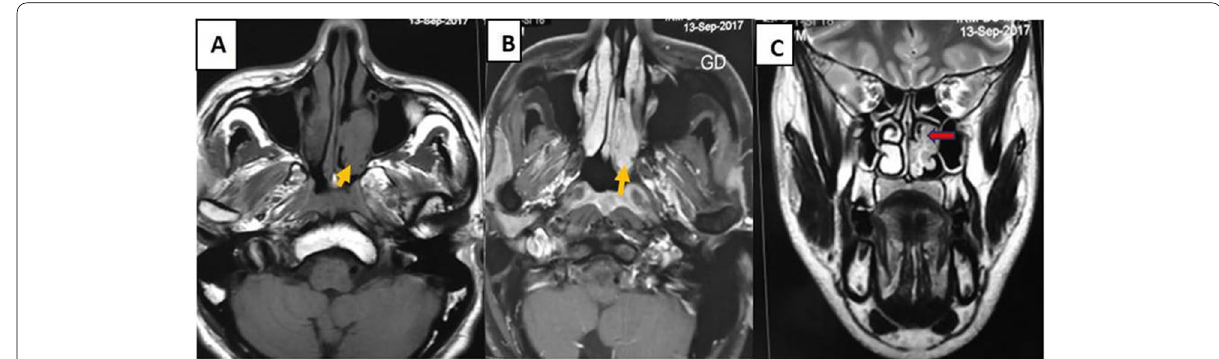
Fig. 4 Axial T1W ( A ), Fat-Sat contrast-enhanced T1W ( B ), and coronal T2W ( C ) MR images showing a mass of the middle left meatus extending to the nasal cavity and homolateral choana (yellow arrow) isointense in T1W, heterogeneously hyperintense in T2W achieving a convoluted cerebriform pattern (red arrow) with moderate and heterogeneous enhancement